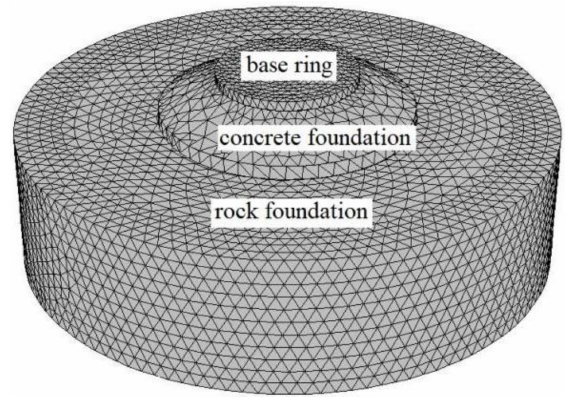
Figure 7. Calculated